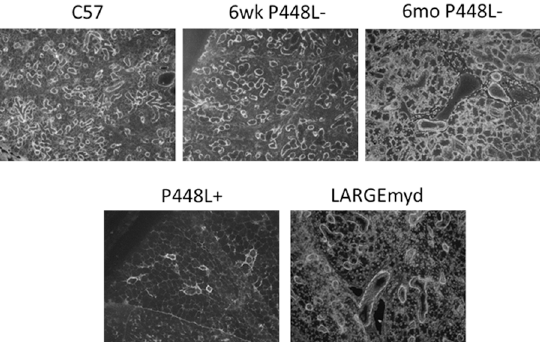
Fig 7. F- α -DG in the salivary gland. Strong IIH6 staining is seen around the striated ducts and acini of C57, P448L- (both 6 weeks and 6 months of age) as well as the LARGE myd . However, detectable IIH6 staining is seen around the striated ducts of P448L+ and not acini. Images are 20X